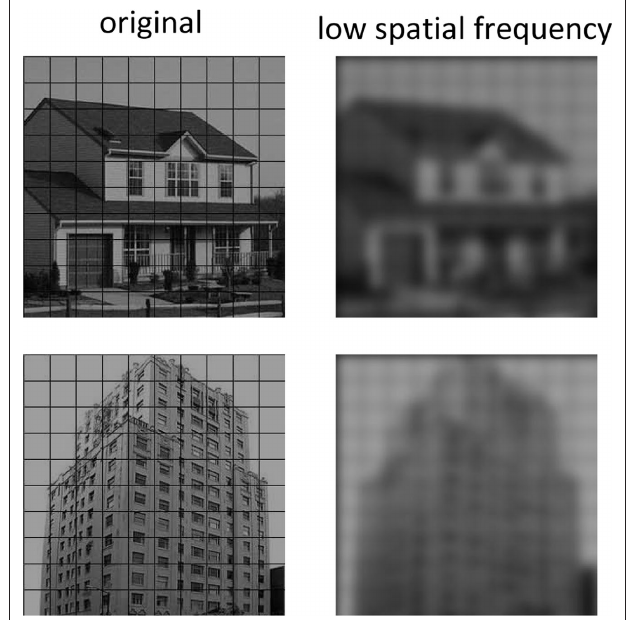
Figure 4 | Frequency content of T2 stimuli. Original and low spatial frequency content of typical house and building T2 stimuli used in this study. It is apparent that house and building stimuli can be discriminated easily based on low spatial frequency information alone. In the low-pass images, building stimuli exhibit a clear vertical elongation; houses, on the other hand, lacked this type of